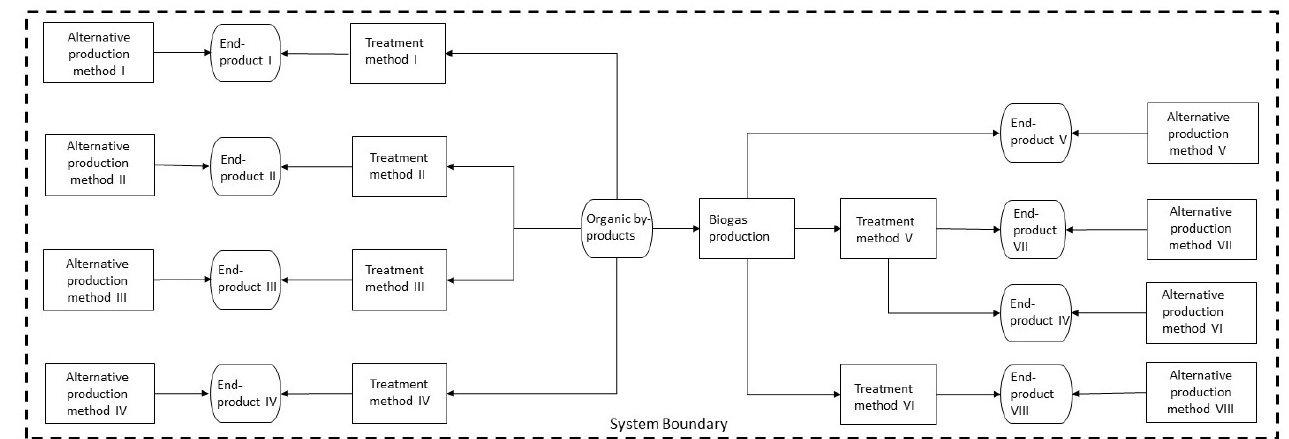
Figure 1. A generic overview of the systems [15]. The system expansion is included (the alternative production methods). The currently used treatment methods are shown to the left in the figure and the possible new treatment methods are shown at the right side and the same arrangement is found in Figures 2–4.